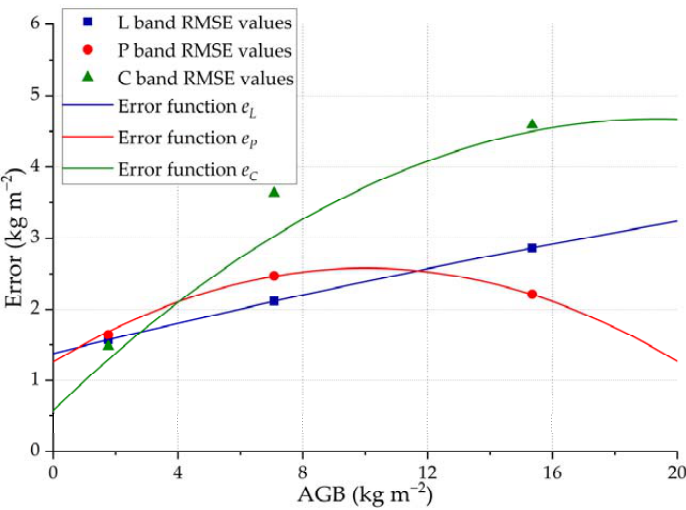
Figure 10. Error functions and RMSE values for the L, P, and C bands as a function of the measured AGB. measured